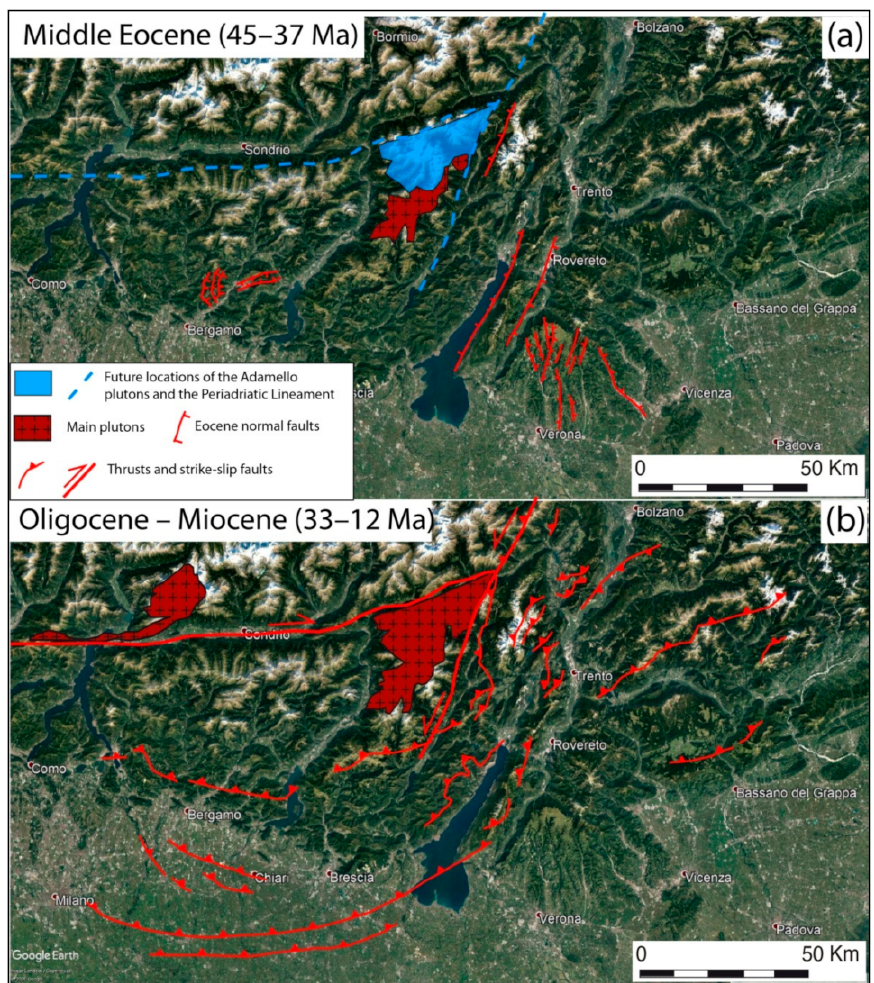
Figure 13. ( a ) Active faults and geodynamic setting in the Southern Alps during Middle Eocene time. ( b ) Active faults and geodynamic setting in the Southern Alps during Oligocene–Miocene times. Satellite imagery from Landsat/Copernicus dataset, Google Earth